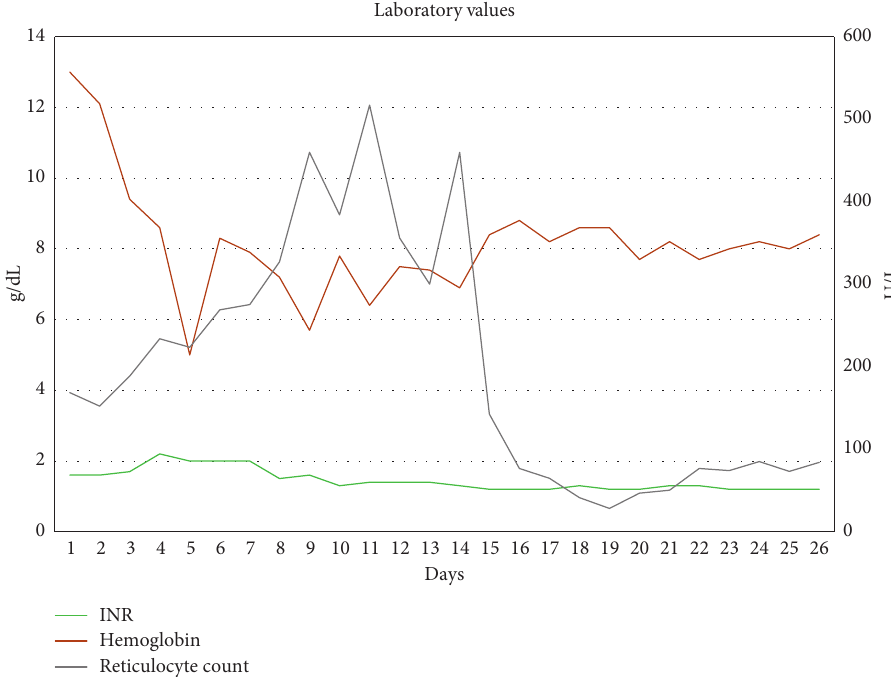
Figure 4: Changes in INR, hemoglobin, and reticulocyte counts during hospitalization are plotted from admission at days